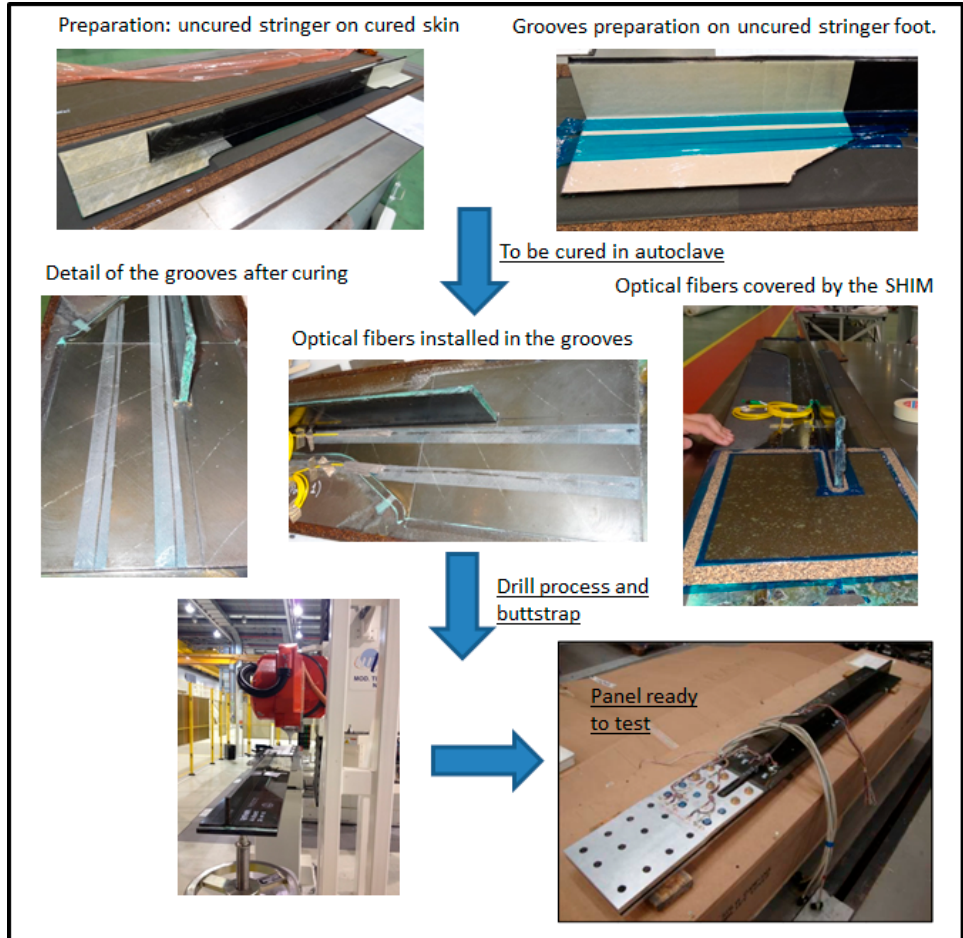
Figure 6. Installation of FBG arrays on the stringer foot.